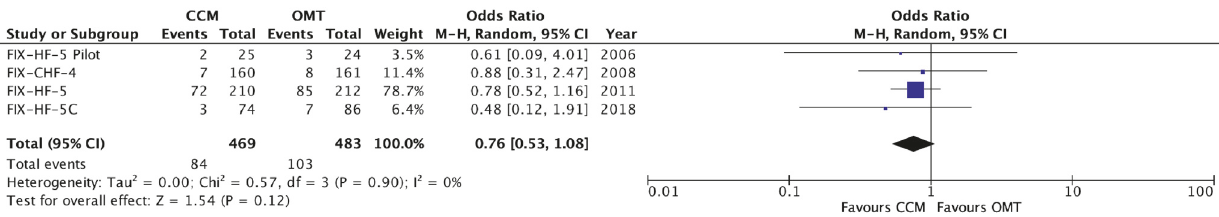
Figure 4: Forest plot of worsening HF/HF-related hospitalizations in the CCM groups versus the control groups. A forest plot of thedata available to us from the 4 RCTs assessing worsening HF and HF-relatedhospitalizations in those with CCMcompared to those with OMT alone. There was a nonsignificant trend in reduced HF hospitalizations in those with CCM.